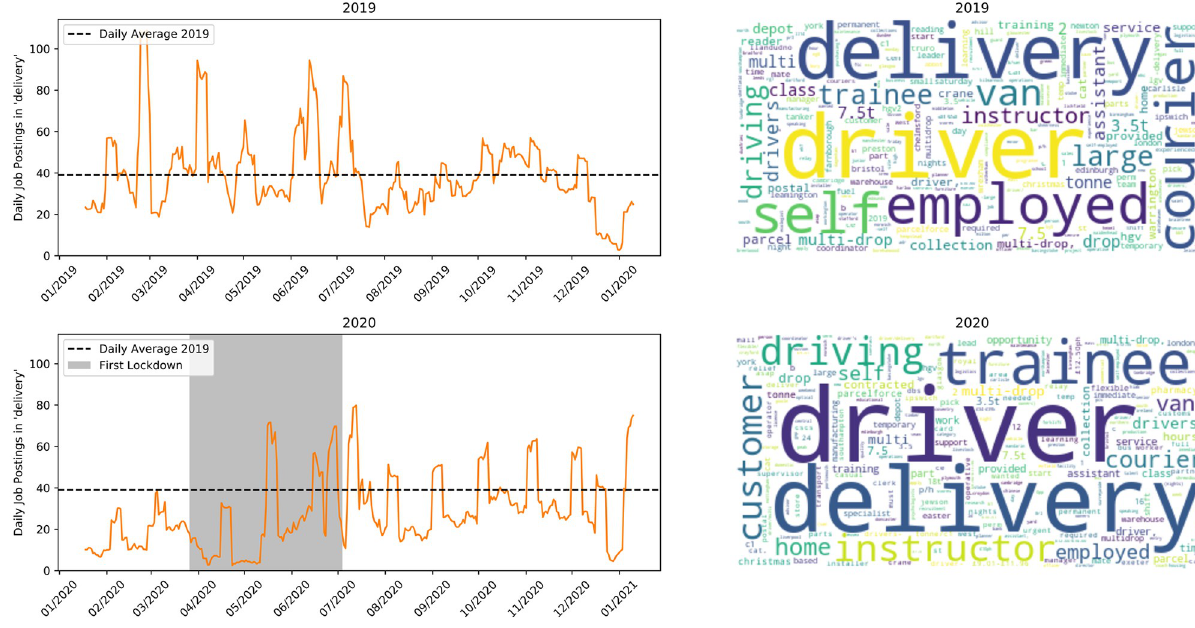
Fig 10. Jobs matching ‘delivery’. Top row is 2019, bottom is